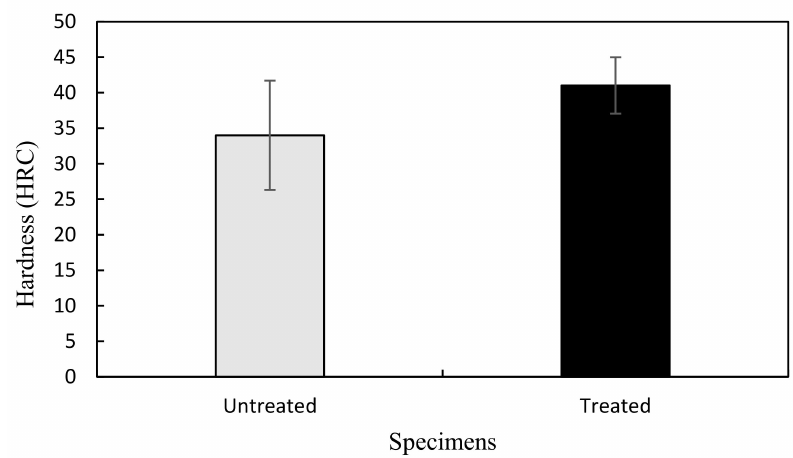
Figure 12. The average hardness of treated and untreated specimens from the Rockwell C test.